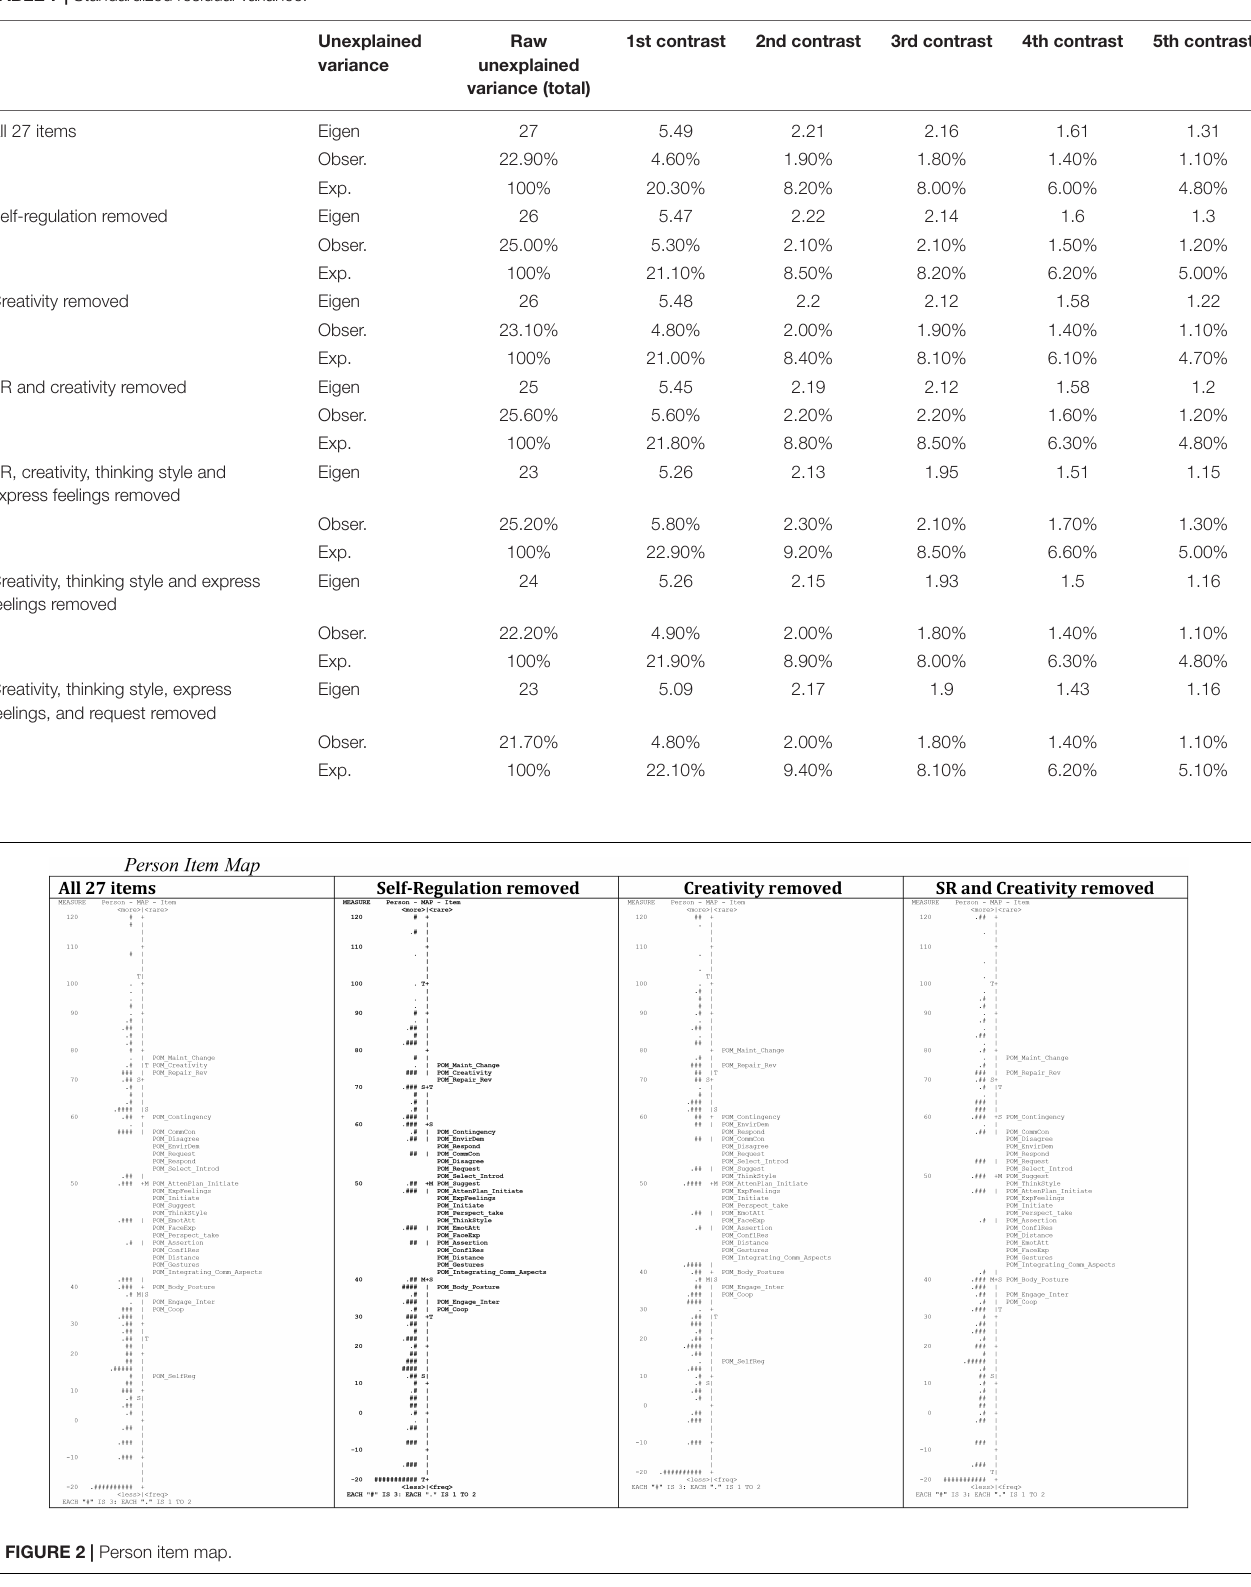
TABLE 7 | Standardized residual variance.